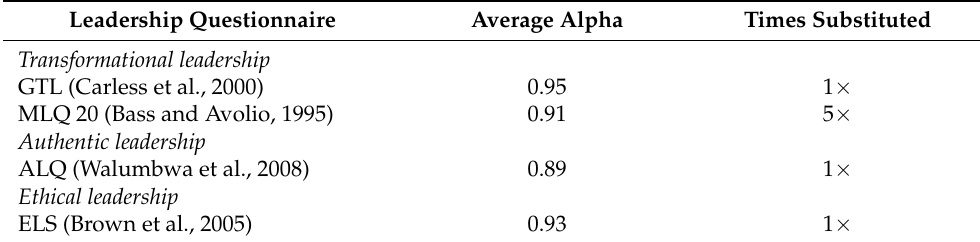
Table A3. Substitution for Cronbach’s alpha of the leadership